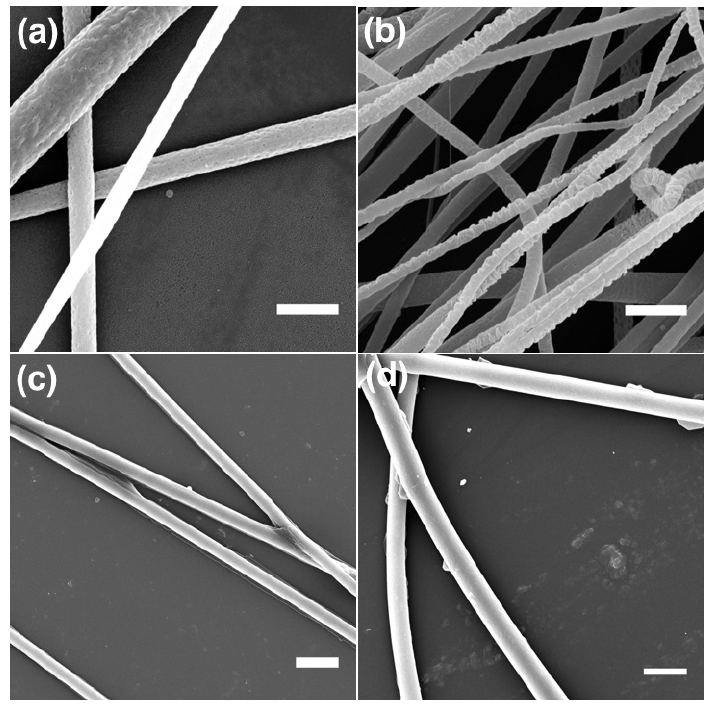
Figure 9. SEM of ( a ) pure PLA fibers (spun from a 9 wt. % solution) without heat treatment; ( b ) the same type of fibers after heating to 80 ◦ C; ( c ) CL-PLA fibers (spun from mixture 2) after UV curing at room temperature and subsequent heating to 55 ◦ C and ( d ) the same type of fibers after UV curing at room temperature and subsequent heating to 80 ◦ C. (scale bars: 10 µ